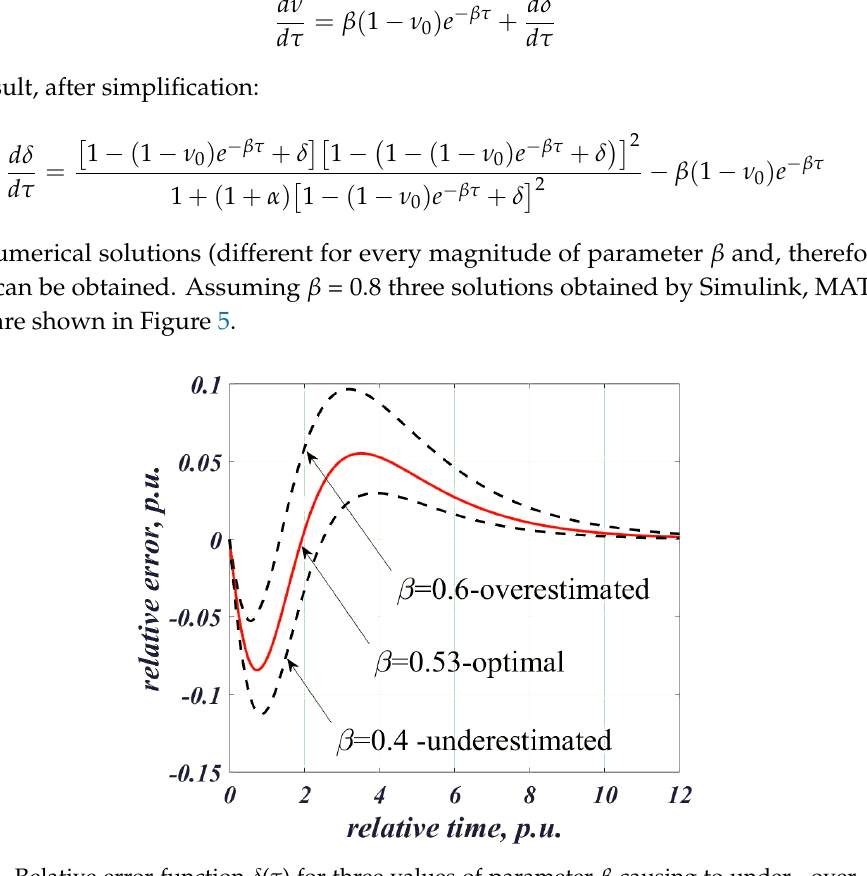
Figure 5. Relative error function δ ( τ ) for three values of parameter β causing to under-, over-, and optimal approximation for ν 0 = 0.7 and α = 0.05.